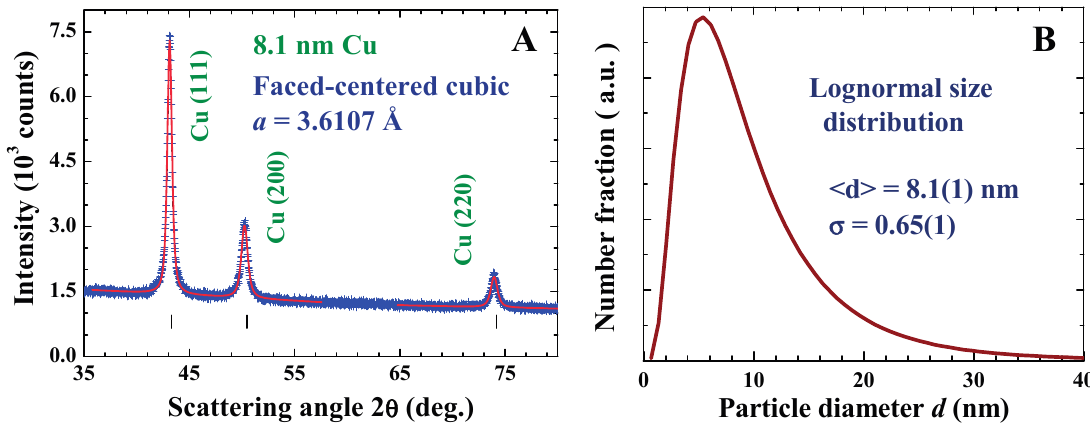
Figure 1. ( A ) X-ray diffraction pattern of the Cu nanoparticle assembly at 300 K, revealing a face-centered cubic crystalline structure. The solid curves indicate the calculated profiles of the diffraction peaks, assuming a lognormal size distribution with a center at 8.1 nm and a standard deviation width of 0.65; and ( B ) size distributions obtained from the X-ray diffraction